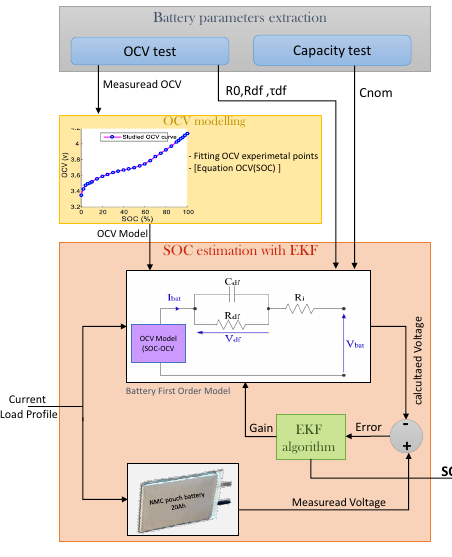
Figure 12. Flowchart of the approach